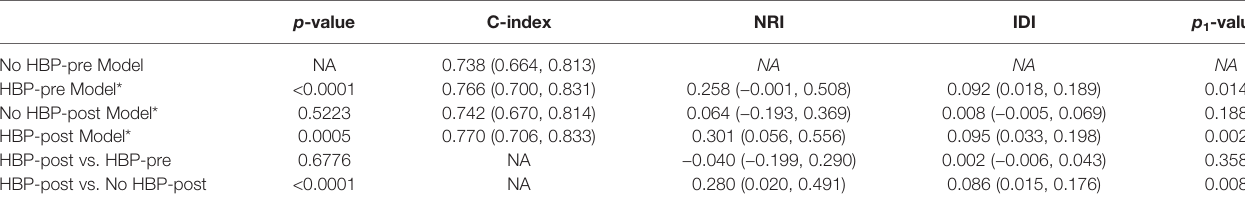
TABLE 4 | Comparison between models.